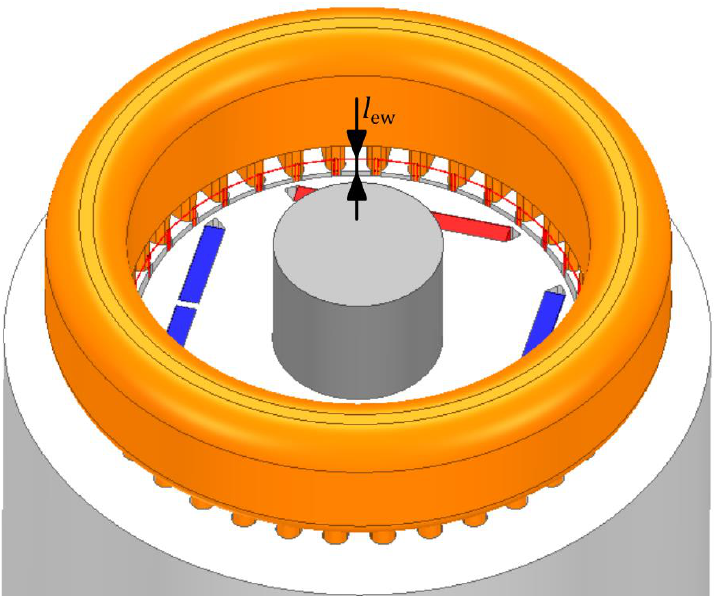
Figure 11. A 3D model of the machine with a visualized shielding winding for l ew = 5 mm.